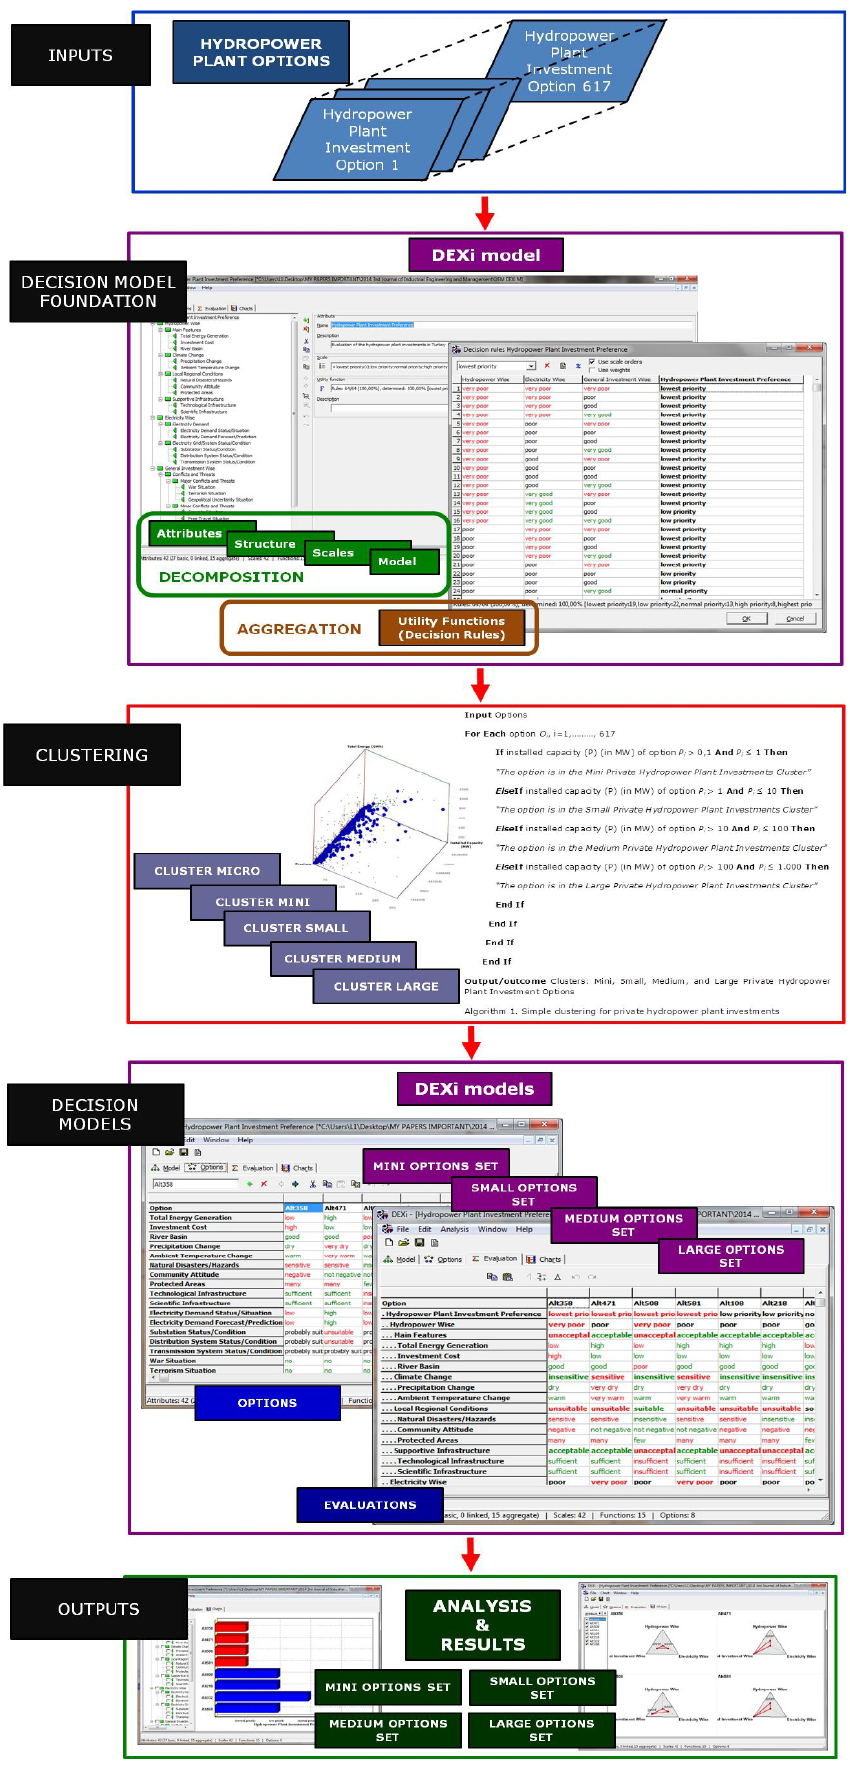
Figure 1. The structure of the framework of the current